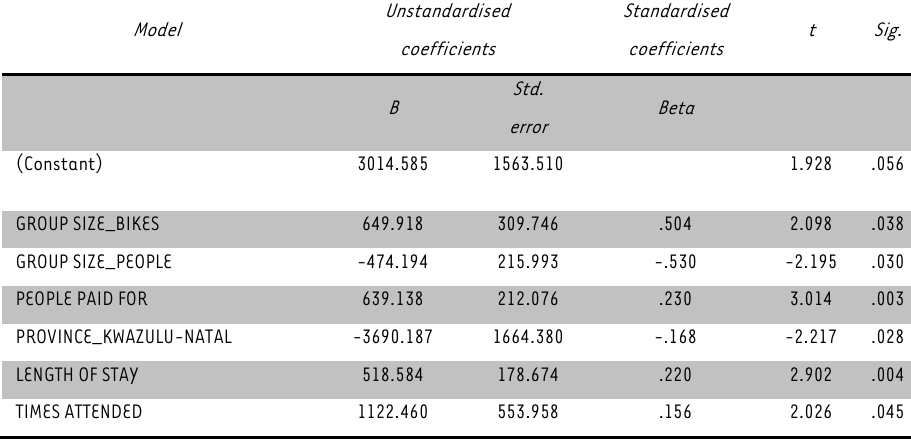
Results from the backward regression analysis: Total